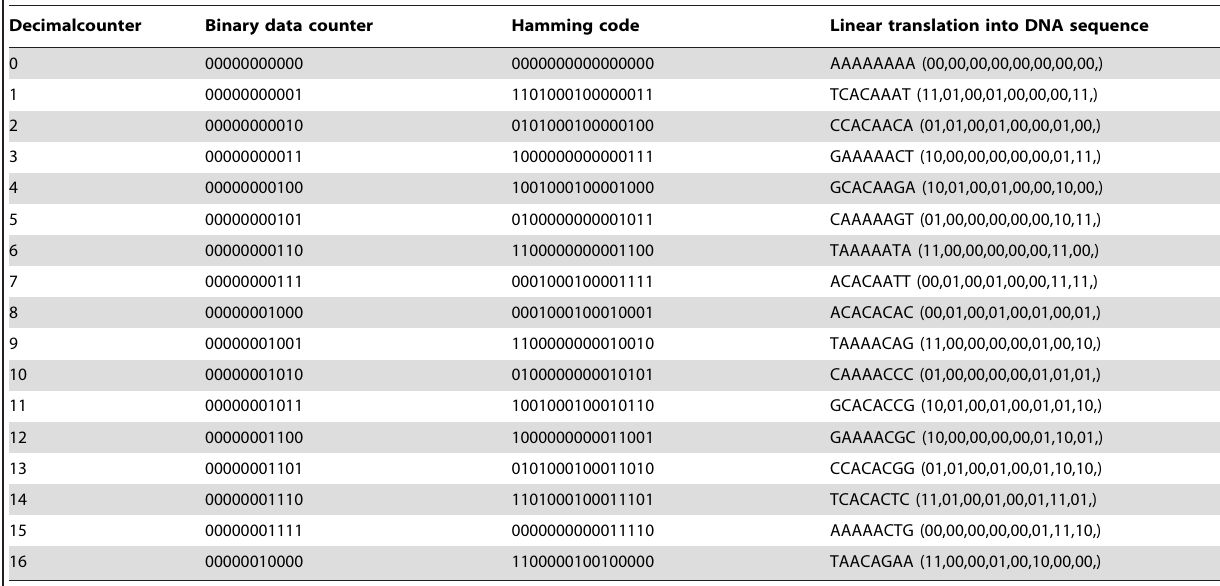
Decimalcounter Binary data